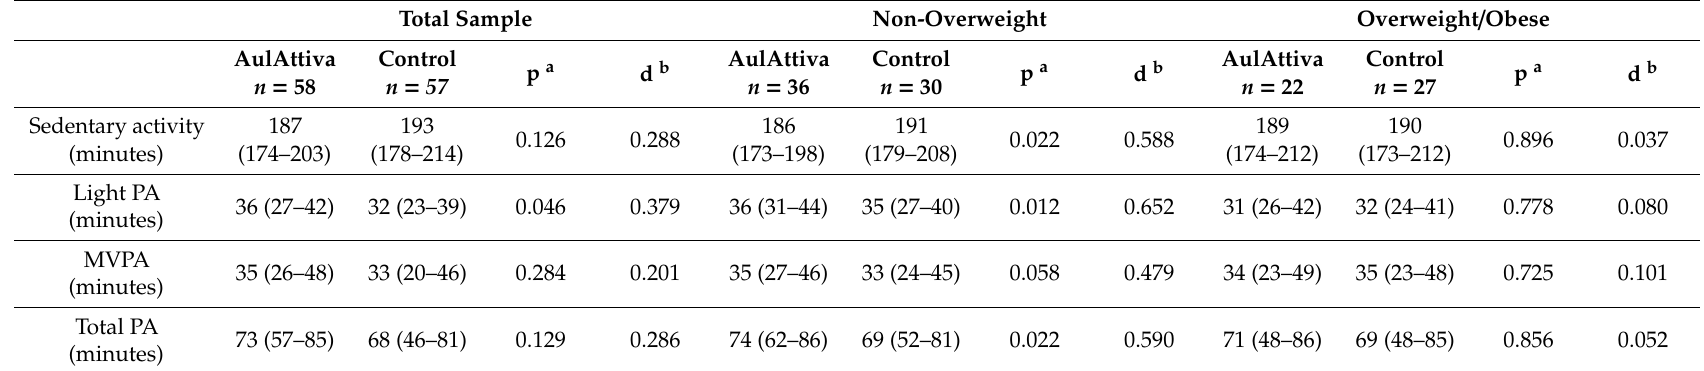
Table 2. Di ff erences in sedentary or physical activity time in the total sample and BMI subgroups with corresponding p values and e ff ect